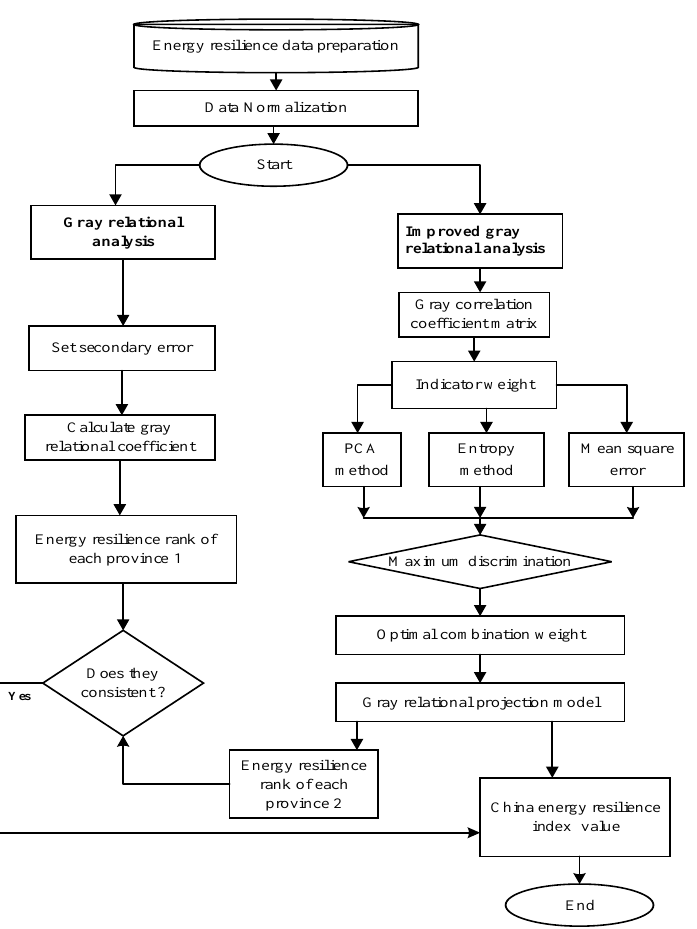
Figure 3. The flowchart of the proposed improved gray relational model.